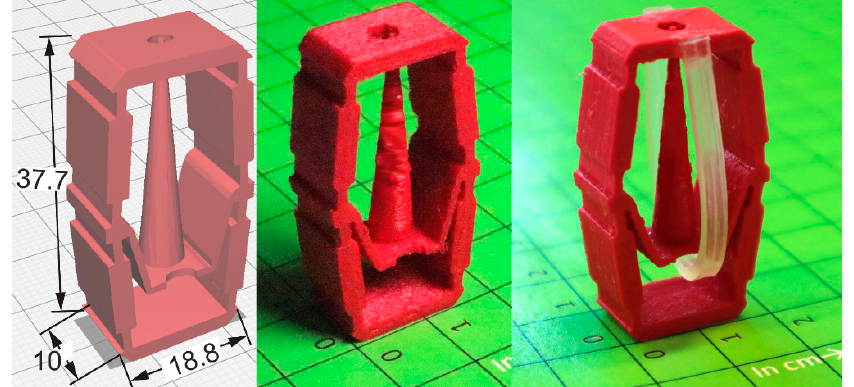
Figure 13. Unit cell with switchable surface topography. Technical drawing ( left , all data are provided in mm.), unit cell after additive manufacturing with Desmopan ® 9370AU ( middle ) and unit cell as assembled with the PEU actuator element ( right ). Centimeter paper was used as a base in the second and third image.